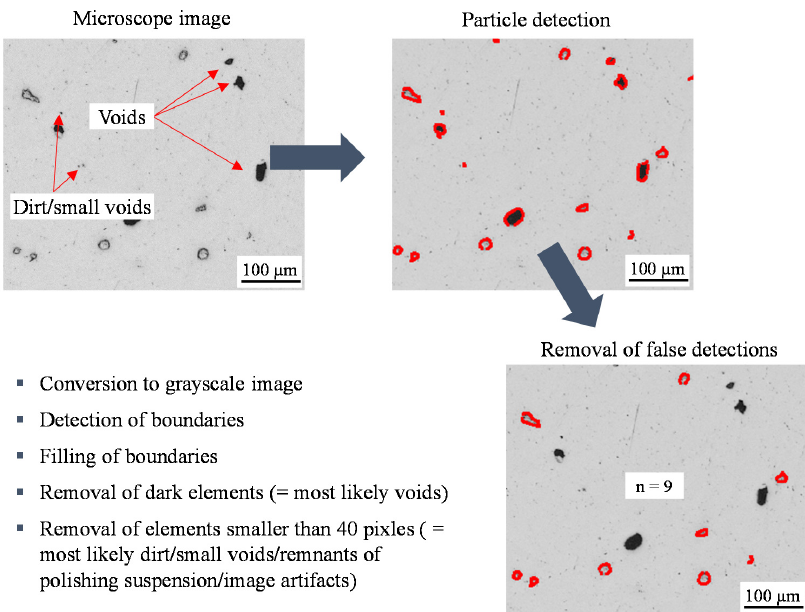
Figure 3. Detection of unmolten particles by automated image analysis.